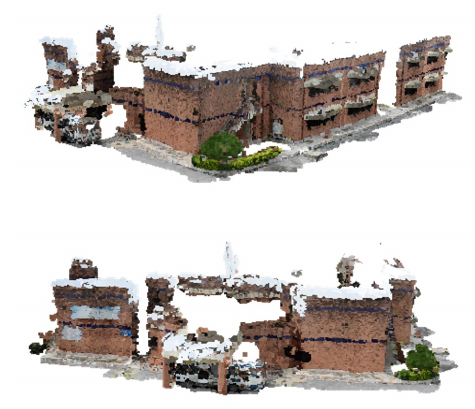
Figure 12. Dense point